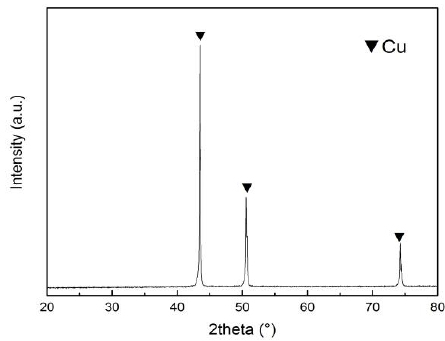
Figure 4. X-ray diffraction of the Cu powder.